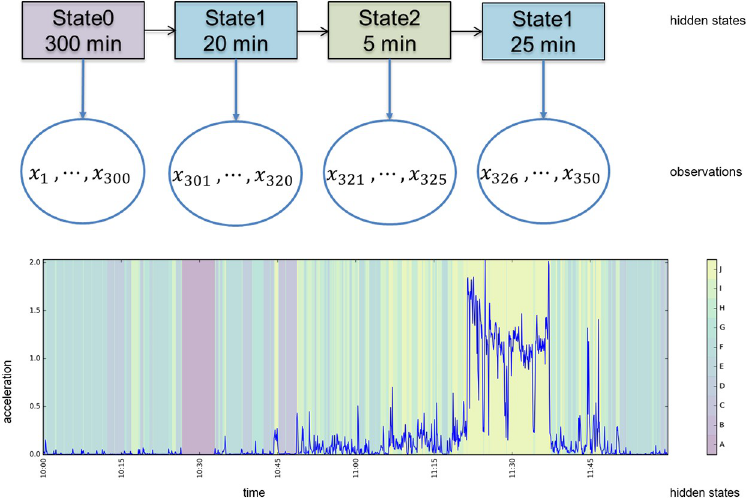
Fig 1. Hidden Semi-Markov model (HSMM), explained schematically (above) and an example of the resulting segmentation (below). The observations (accelerometer metrics), denoted by x, are segmented into states of variable length. Segmentation by the HSMM is based on the model distributions for duration and observations, and transition probabilities between states.